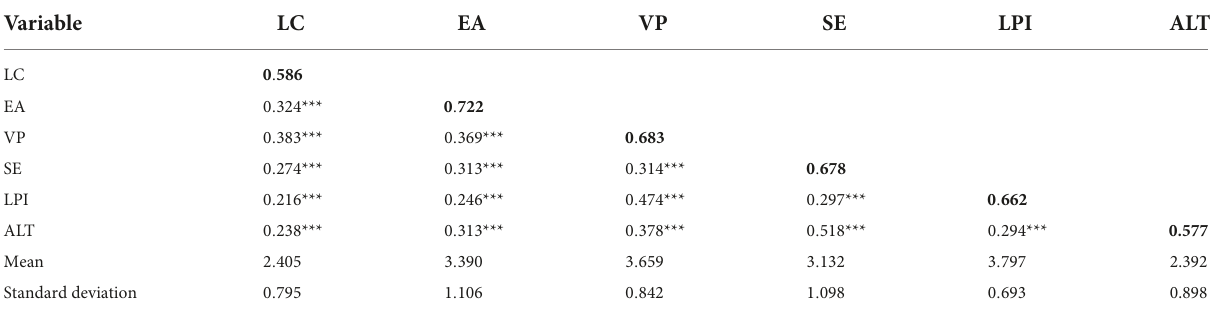
TABLE 5 Descriptive statistics of key variables.